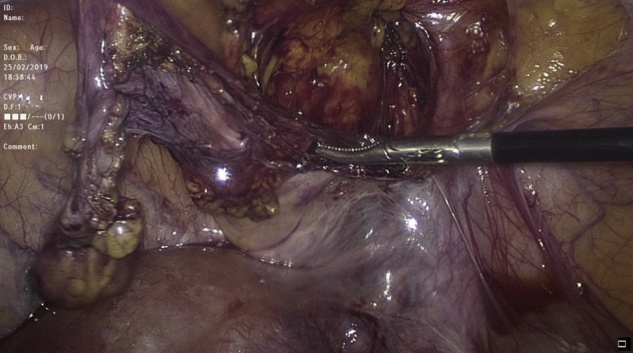
Excision of the sac.